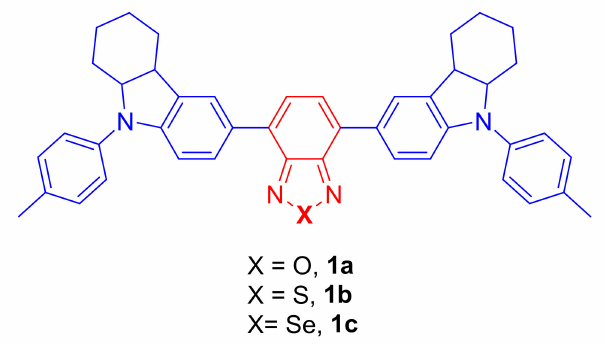
Figure 1. Chemical structures of the dyes